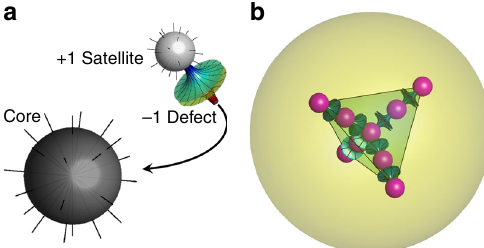
Fig. 1 Inclusion self-assembly process. a Illustration of the satellite to core attachment process. b Diagram showing a topologically stabilized structure with tetrahedral symmetry: water droplets are shown by magenta balls, hyperbolic defects are shown in cyan and the nematic region is shown